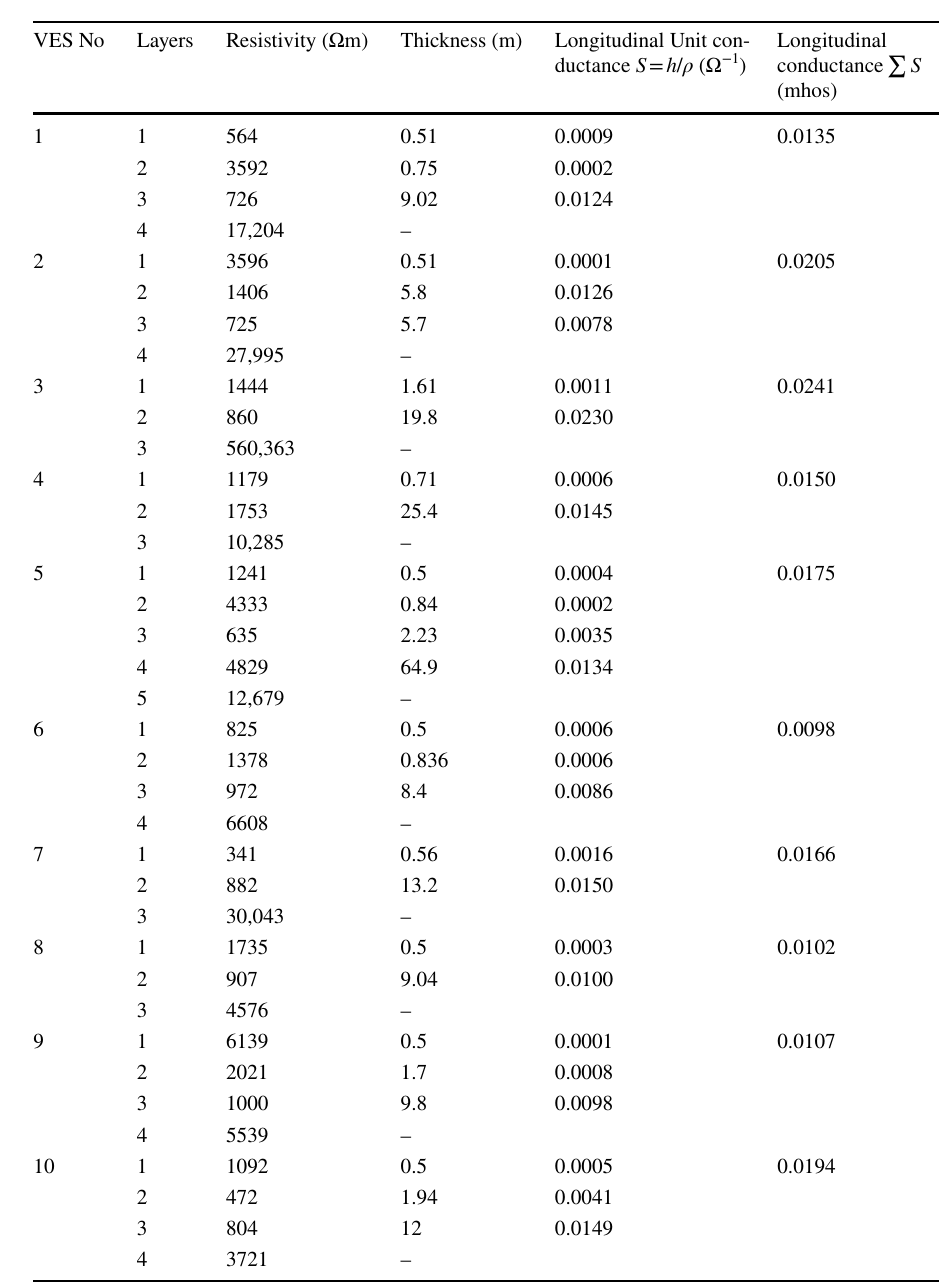
Table 4 Geoelectric properties and Dar-Zarrouk